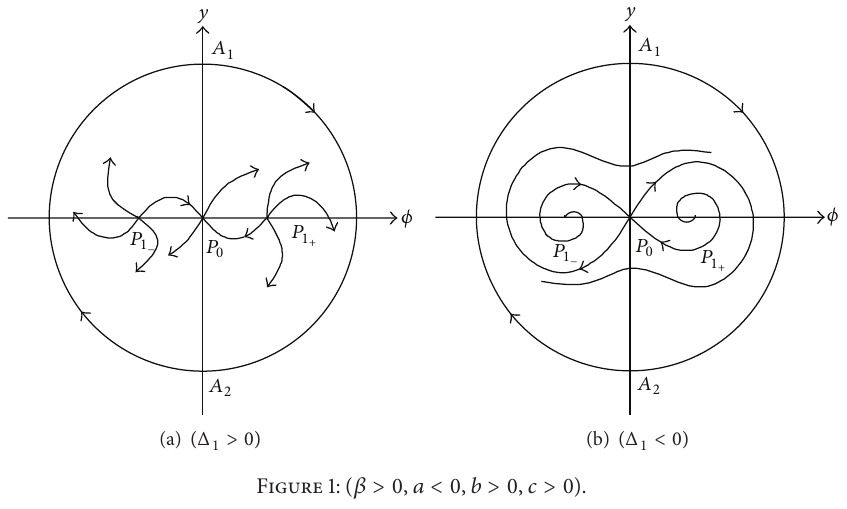
Figure 1: (𝛽 > 0 , 𝑎 < 0 , 𝑏 > 0 , 𝑐 > 0 ).